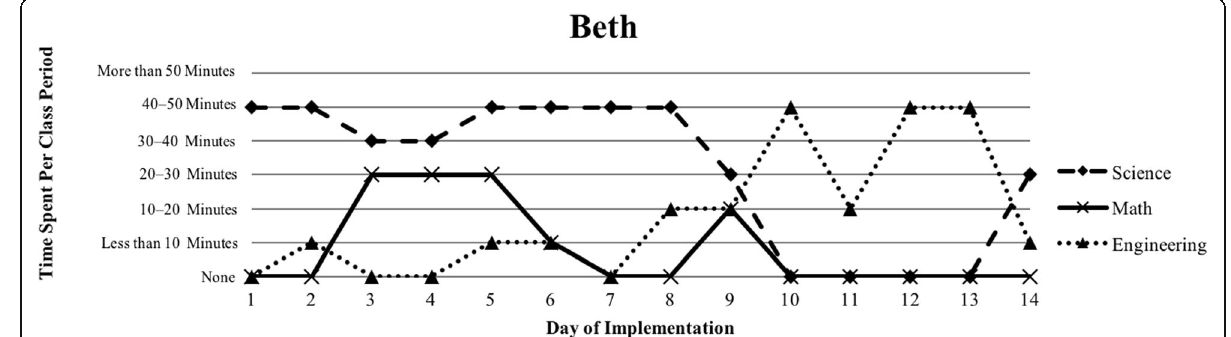
Fig. 4 Beth ’ s implementation of the Heat Transfer 2 in her 6th grade science